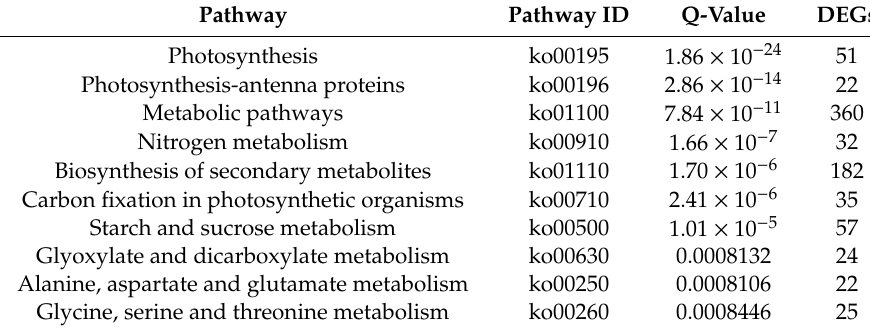
Table 3. The top-10 KEGG pathways mapping enriched di ff erential progress.